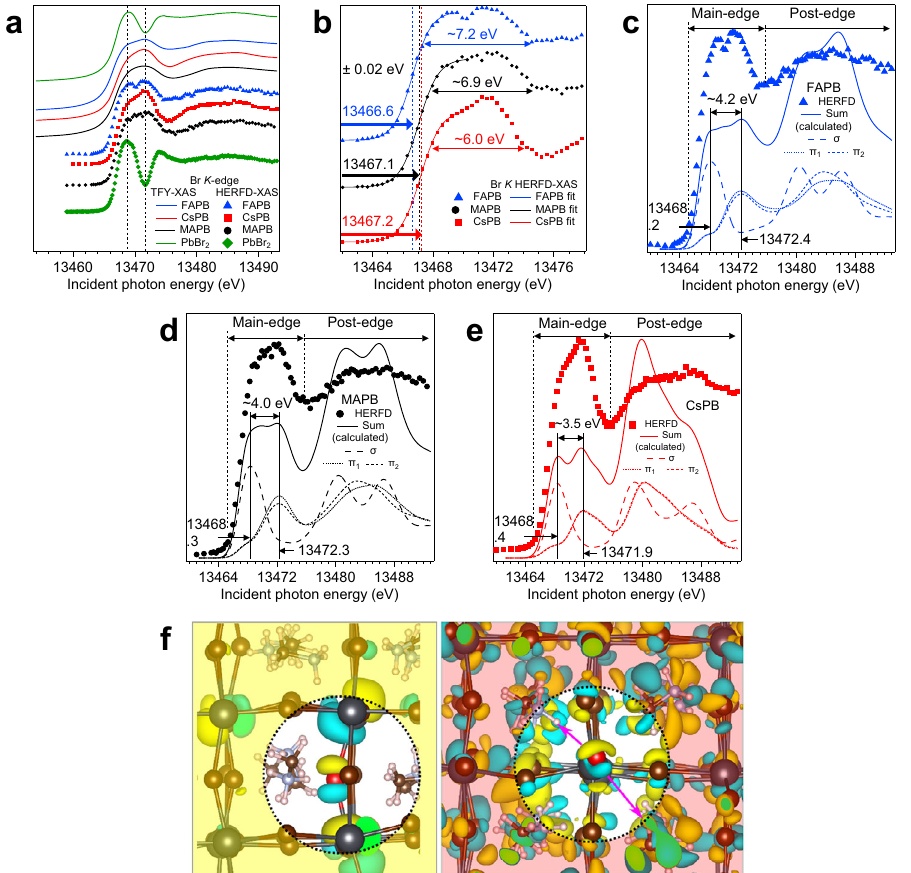
Fig. 2 Experimental and calculated Br K -edge XAS spectra of FAPB, MAPB and CsPB. a Comparison of the Total Fluorescence Yield X-ray absorption spectroscopy (TFY-XAS, lines) and High Energy Resolution Fluorescence Detected X-ray absorption spectroscopy (HERFD-XAS, symbols) spectra of PbBr 2 (green), FAPB (blue), MAPB (black) and CsPB (red). The vertical dashed lines are guides to the eye for features of interest. b Comparison of the HERFD- XAS main-edge spectra of the APB compounds. The absorption onsets are quanti fi ed with sigmoid fi ts and the main-edge widths are estimated (see text). c – e Experimental versus calculated Br K XAS spectra for FAPB, MAPB and CsPB. The total calculated spectrum is shown along with its constituent distributions. The sigma- and pi-symmetry distributions of states are denoted as σ , π 1 and π 2 . f Crystal structure of MAPB, shown with the molecular orbitals associated with σ - and π -symmetry states probed with XAS. The left panel shows the σ orbitals (in cyan and yellow) emanating from the Br atom (in red). The right panel shows the π orbitals (in cyan and yellow) emanating from the Br atom (in red). The lobes of the π orbitals point towards the MA + molecule; the pointing is highlighted by the magenta